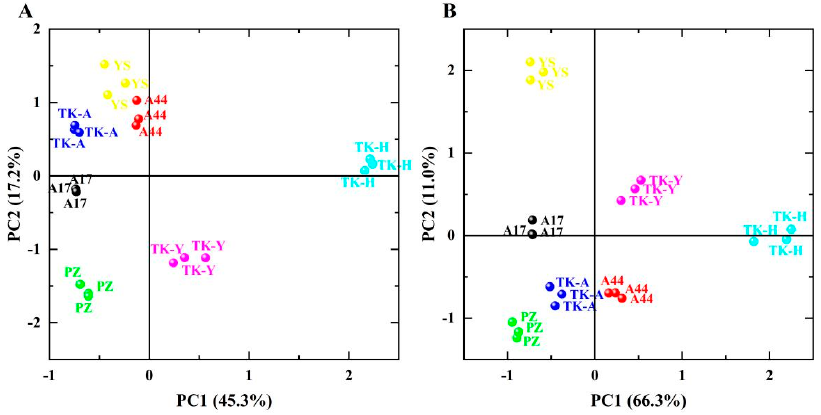
Figure 4. Principal component analysis of leaves ( A ) and roots ( B ) of dandelion (score plots of PC1 and PC2).